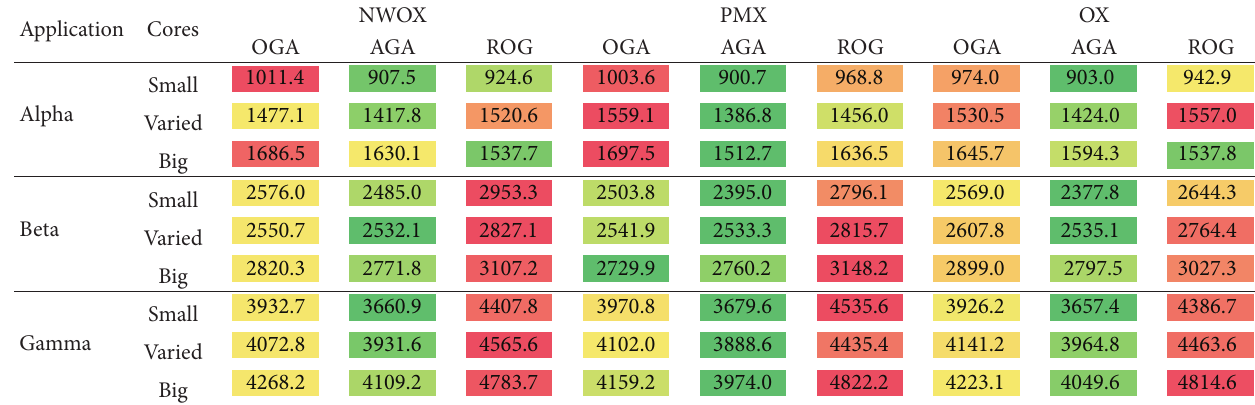
Table 3: Minimum communication costs obtained from the GAs.